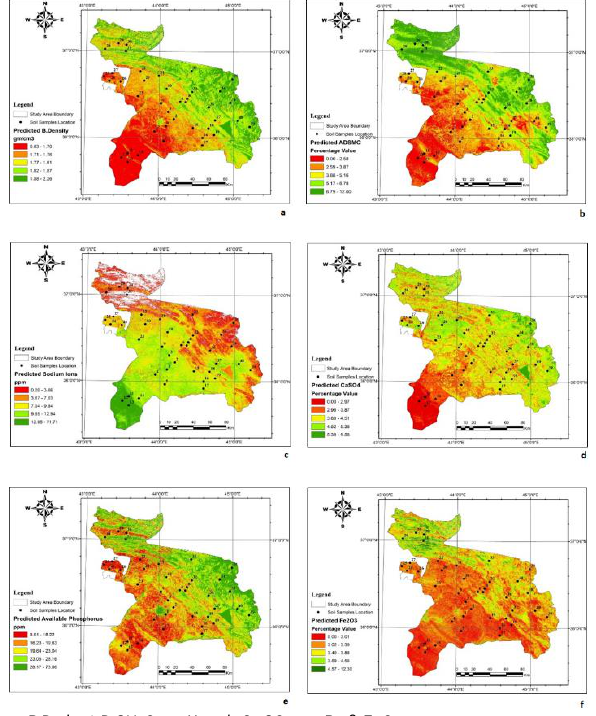
Figure 4. The regression-based maps of the spatial distribution of the studied surface soil properties